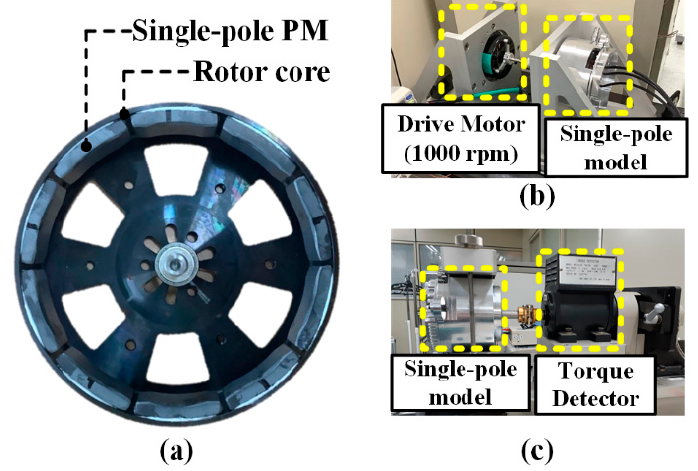
Figure 7. ( a ) PM and rotor core of the manufactured single-pole model. Experimental set up for: Back EMF and ( c ) cogging ( b ) Back EMF and ( c ) cogging torque.